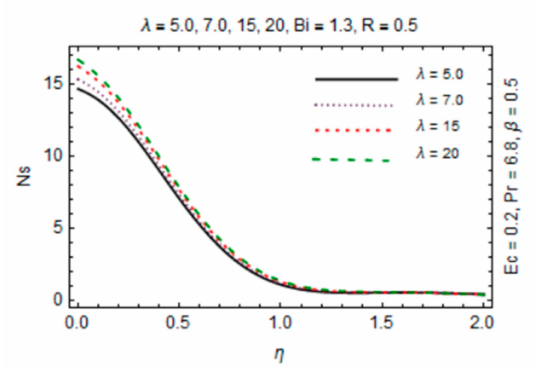
Figure 15. β verses entropy generation number.